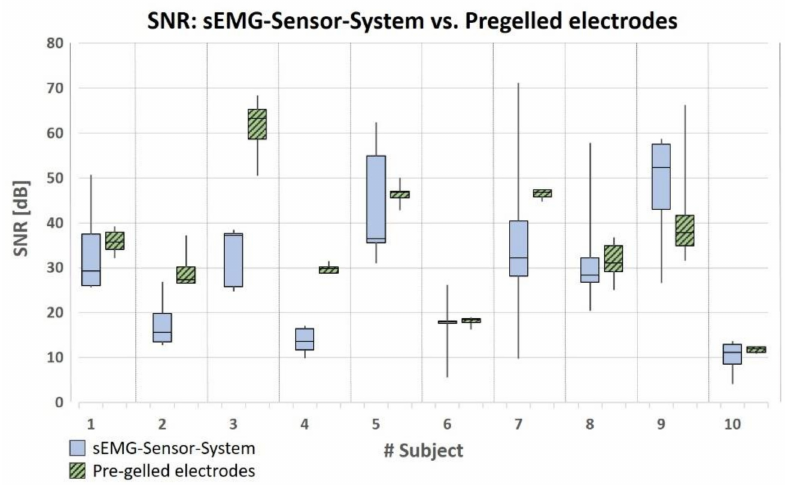
Figure 7. Signal-to-noise ratio (SNR) during the phases of muscular activity of the biceps muscle for the sEMG signal of the first relevant channel of the sEMG sensor system (dry electrodes) and a sEMG recording with the commercial sEMG system (pre-gelled electrodes). Electrode placement and signal processing complied with the SENIAM